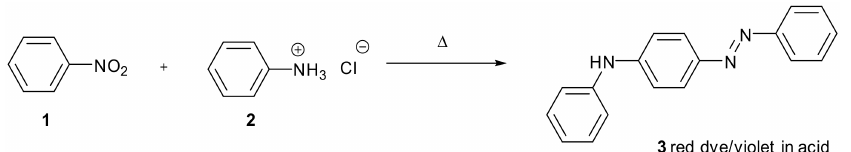
Figure 1. Acid catalysed reaction of nitrobenzene 1 with aniline hydrochloride 2 forming red dye 3 which is violet in